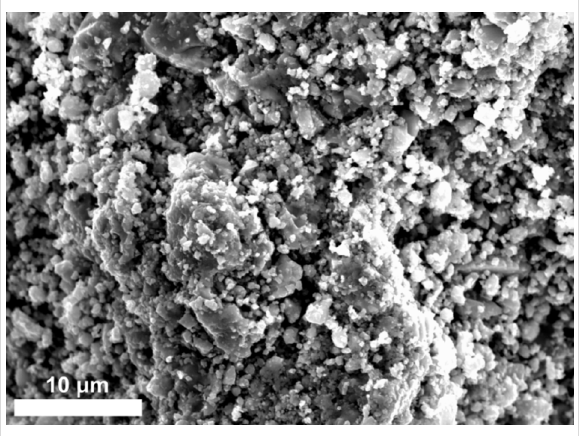
Figure 11: SEM image of SnO 2 particles synthesized with PVP ( M w = 58 000).